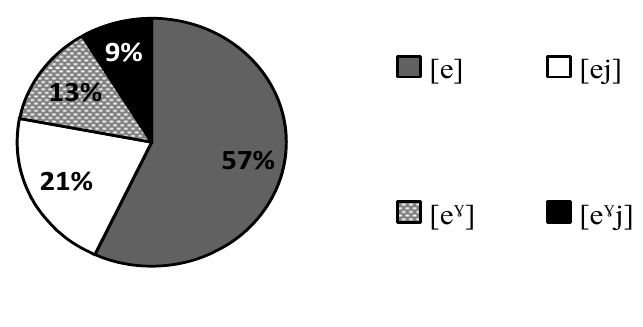
Fig. 1 The Close-mid Front Unrounded Vowel in Stressed and Opened Syllable Position. This graph diagram exemplifies a mapping form from /e/ input to a set of outputs ([e], [ej], [e ˠ ], [e ˠ j]). This shows also the percentage of the occurrences considering both the context syllable and the stressed position in the